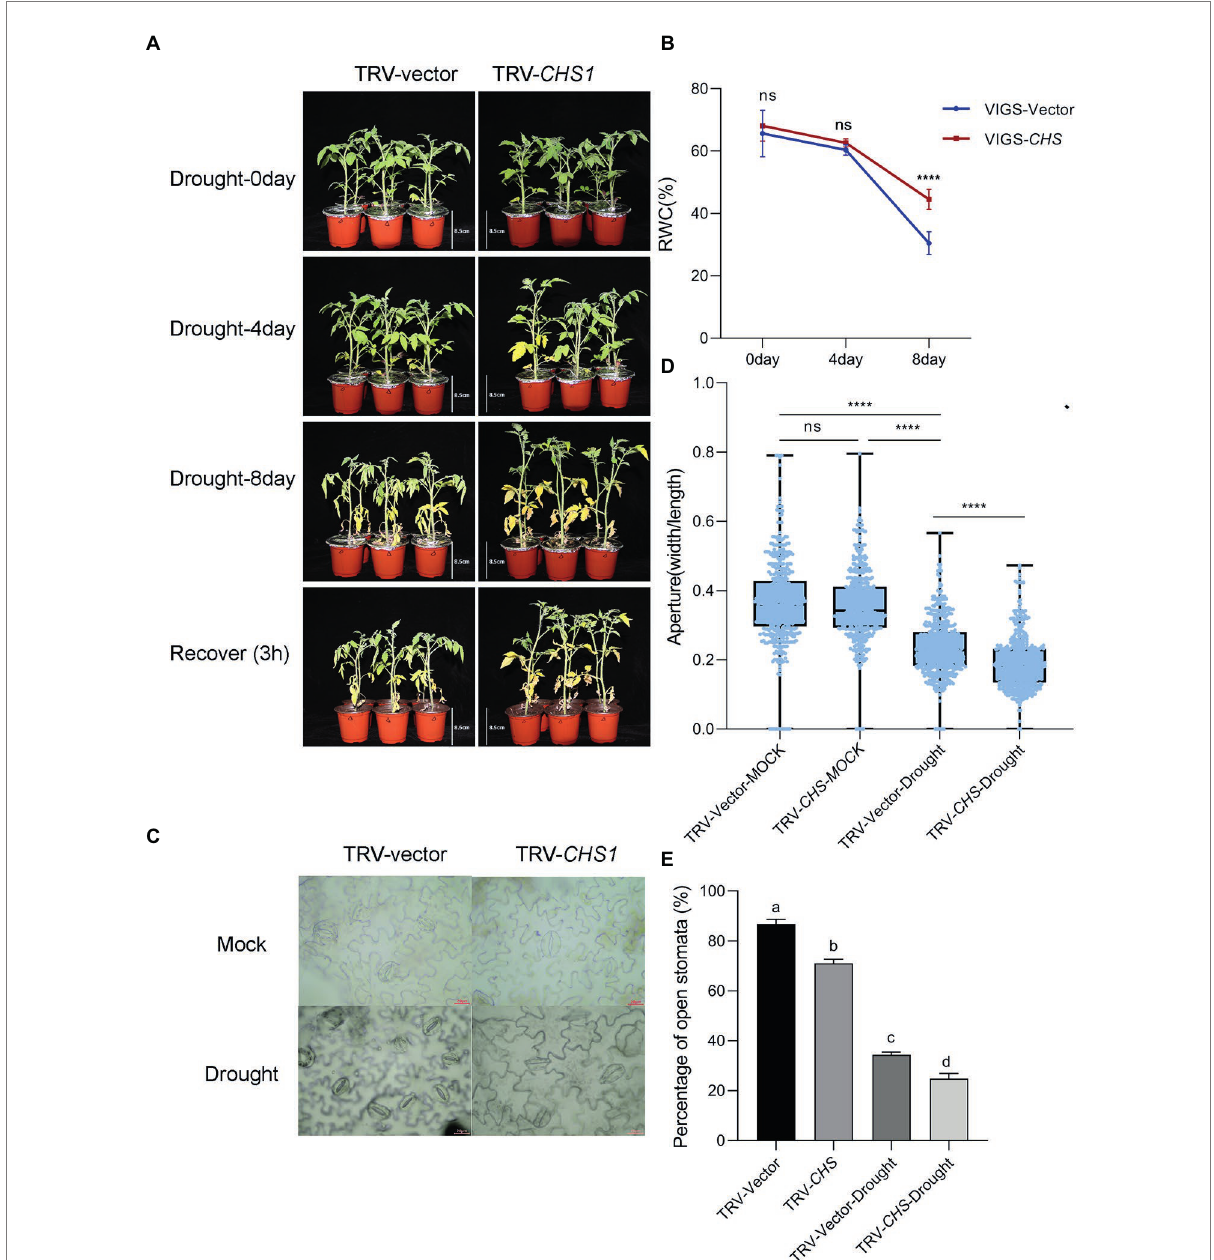
FIGURE 8 SlCHS1 -silenced plants were more tolerant to drought. The phenotype (A) and RWC (B) of TRV-vector and TRV- CHS1 plants cultivated under 8-day water loss and mock conditions (bar = 8.5 cm). (C) Typical images of stomata in TRV-vector and TRV- CHS1 plants cultivated under 8-day water loss conditions (bar = 20 μ m). (D,E) Stomatal aperture ( n = 500) and the percentage of open stomata (170 for each replicate, three replicates, n = 510) in TRV-vector and TRV- CHS1 plants with and without 8 days of water loss. Data were obtained from three experiments. Asterisks represent significant differences (**** p < 0.0001), and different letters indicate significant differences ( p < 0.001) determined using Tukey’s multiple comparisons